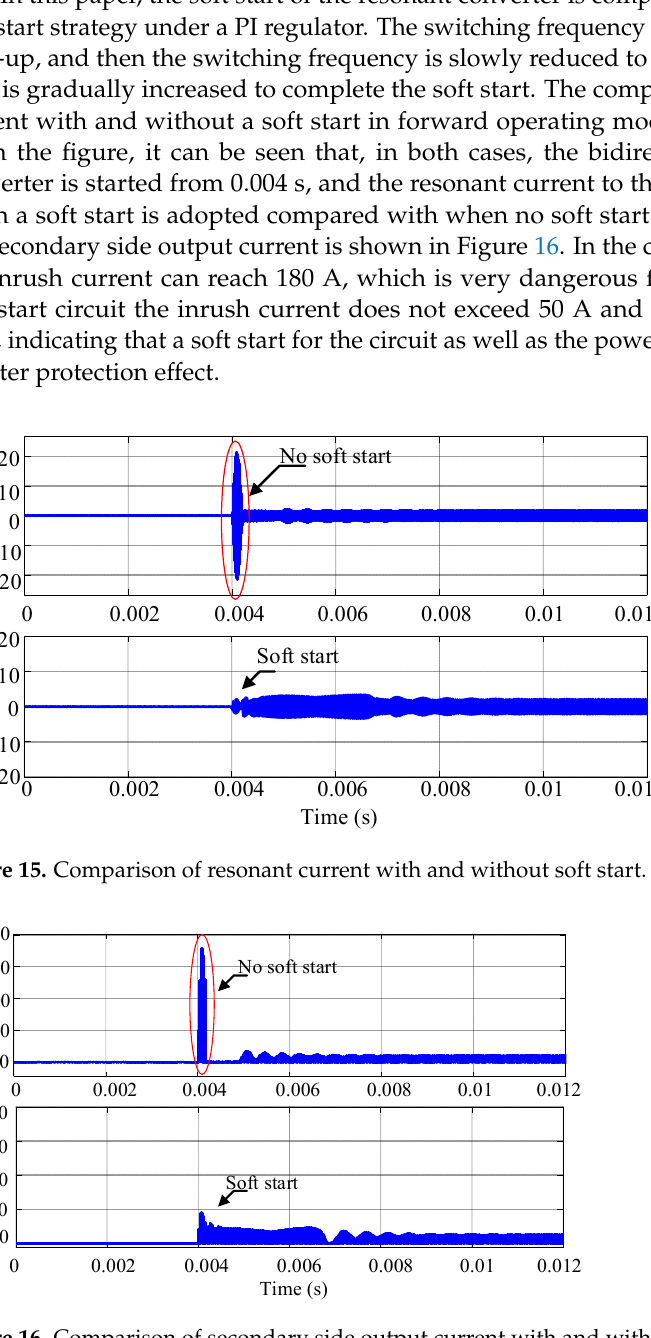
Table 1. Design of the charging system. Symbol